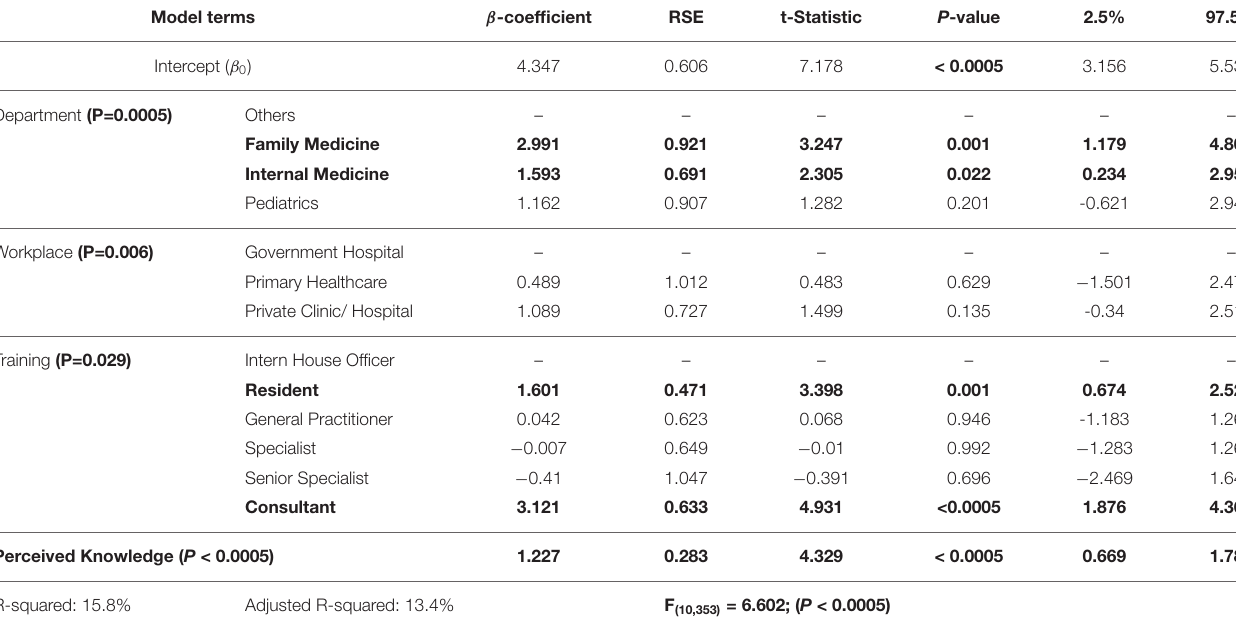
TABLE 4 | Adult vaccination knowledge—multiple linear regression (ordinary least squares).